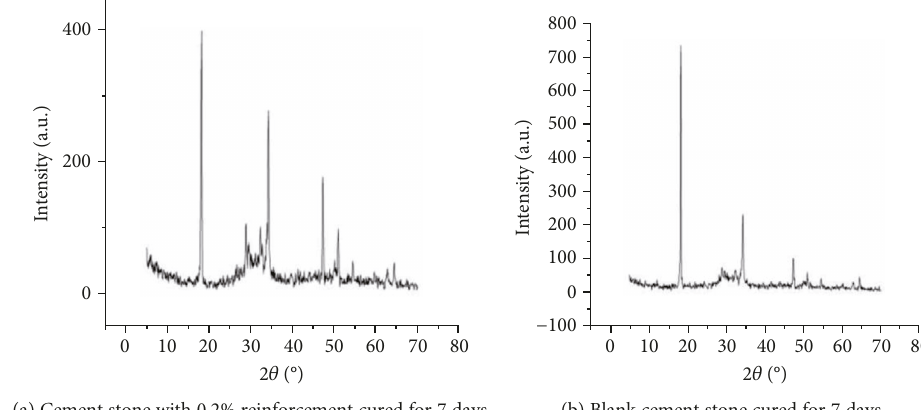
Figure 9: XRD pattern of cement